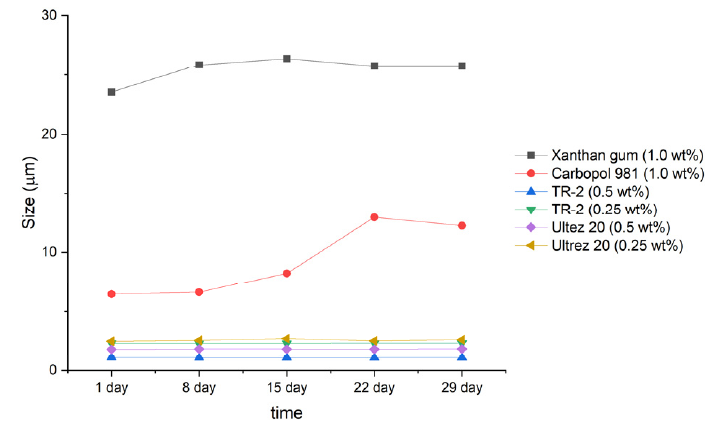
Figure 3. Particle size distribution of emulsions with respect to storage time.